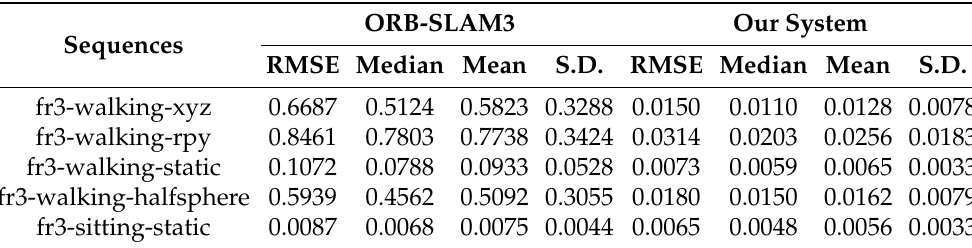
Figure 6. Dynamic point elimination effect: ( a ) the feature point distribution in a frame of tracking; ( b ) the result after eliminating dynamic points. Table 1. Results of Absolute Pose Error (APE includes RMSE [m], Median [m], Mean [m], S.D. [m]).